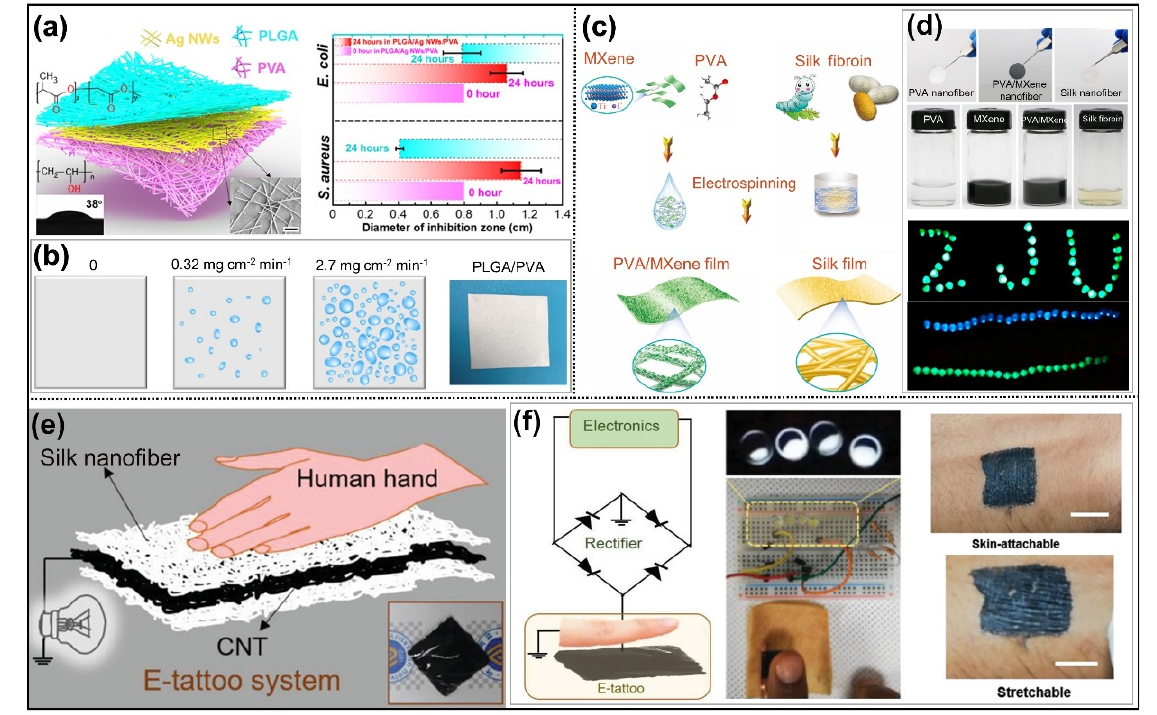
Figure 7. Triboelectric materials based on biodegradable nanofibers applied for energy harvesting. ( a ) A biodegradable and antibacterial PLGA/PVA nanofiber film for TENG. ( b ) The schematic illustration of sweat on the PLGA/PVA e-skin. Reprinted with permission from Ref. [55]. Copyright 2020 Science. ( c ) The preparation of silk and PVA/Mxene-based nanofiber film for TENG. ( d ) The obtained nanofiber films yield high power density. Reprinted with permission from Ref. [56]. Copyright 2019 Elsevier. ( e ) A sandwich structured silk nanofiber film for TENG. ( f ) The flexible silk film can be adhered directly to the human skin. Reprinted with permission from Ref. [57]. Copyright 2021 Wiley ‐ VCH.